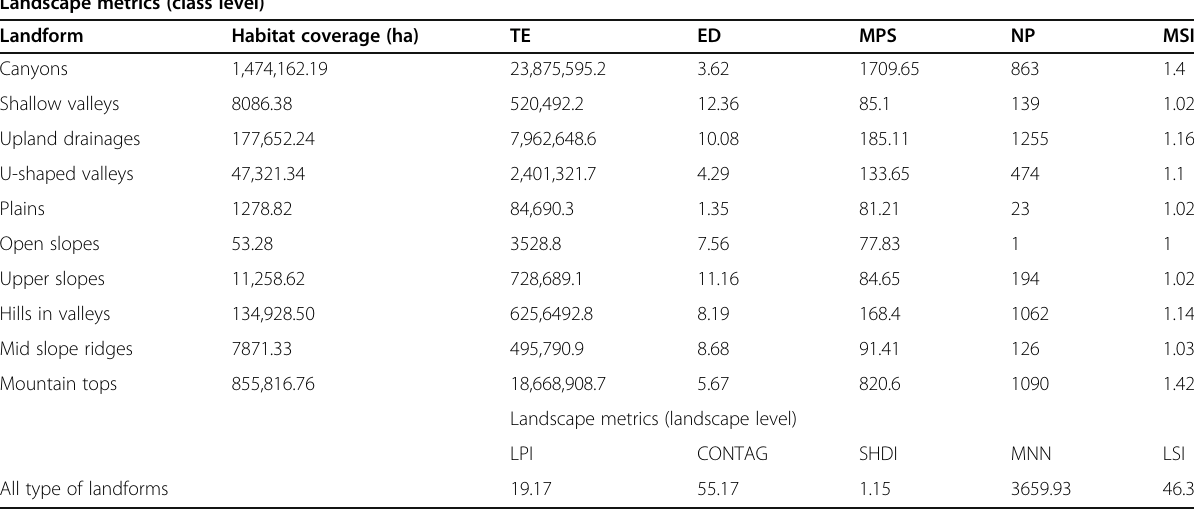
Table 7 Evaluation of the distribution of suitable habitat of Amygdalus scoparia in landform classes based on the landscape metrics